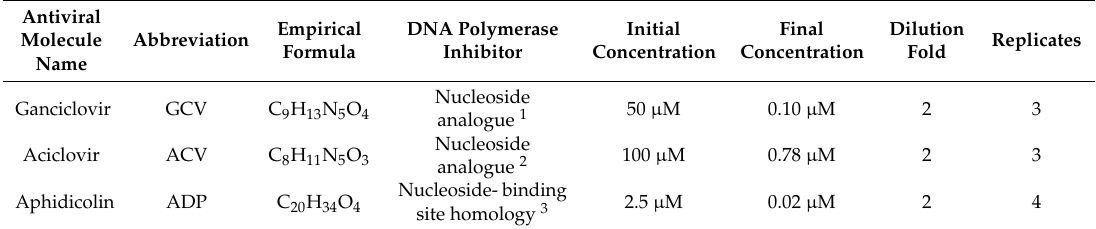
Table 1. Antiviral molecules tested against the newly isolated equid herpesvirus 1 (EHV-1) strain (FR-56628) and EHV-1 strains FR-6815 and